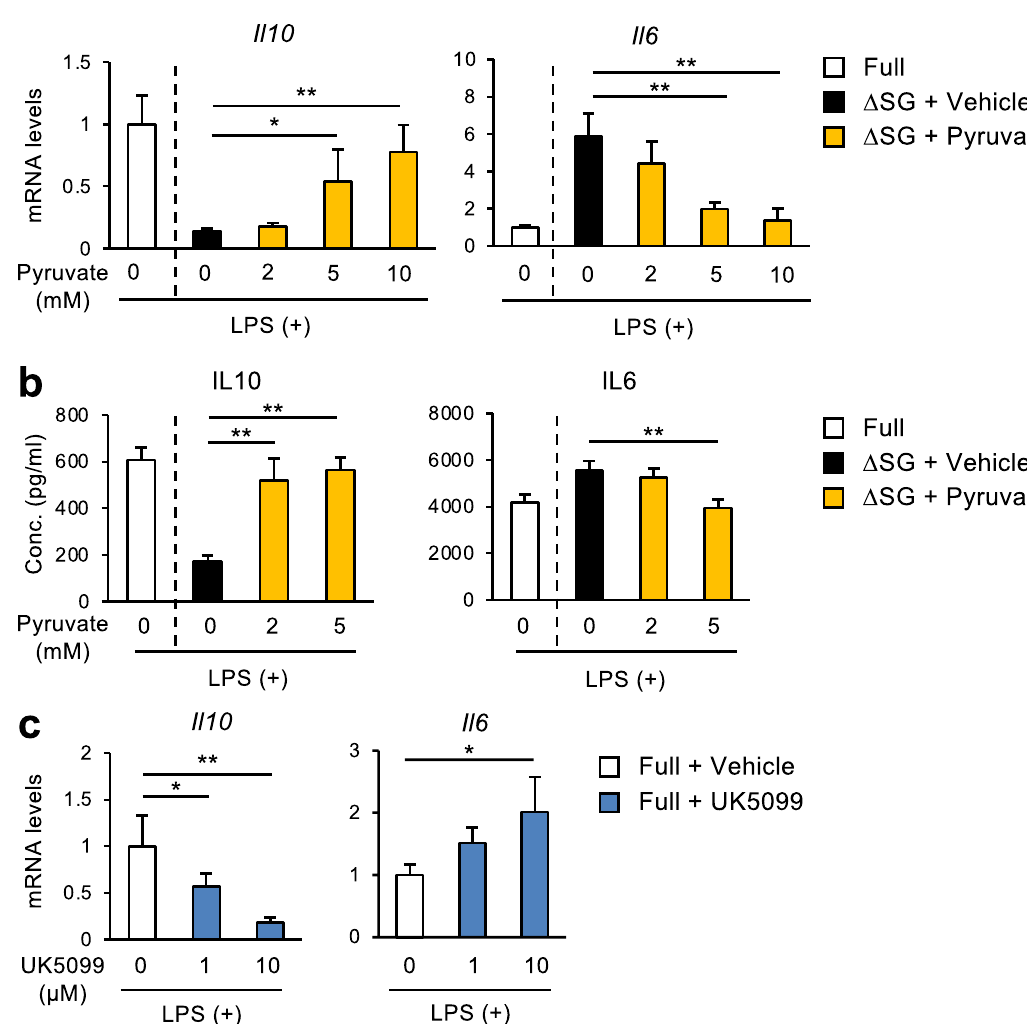
Figure 4. Reduction of mitochondrial pyruvate transport by serine and glycine deprivation is a cause of aberrant cytokine production. ( a , b ) Gene expression ( a ) and production ( b ) of cytokines in BMDMs. BMDMs were cultured in Full or ∆SG medium with indicated concentration of pyruvate for 24 h, followed by stimulation with LPS (100 ng/ml) for 24 h (n = 4). ( c ) Gene expression of Il10 and Il6 in BMDMs. BMDMs were cultured in Full with indicated concentration of UK5099 (an inhibitor of mitochondrial pyruvate carrier) for 24 h, followed by stimulation with LPS (100 ng/ml) for 24 h (n = 4). Values are means ± 95% CI. Statistical analysis was performed with one-way ANOVA Dunnett’s test (compared to ∆SG + Vehicle ( a , b ); Full + Vehicle ( c )). * p < 0.05; ** p < 0.01. See also Supplementary Figs. S5, S6, and